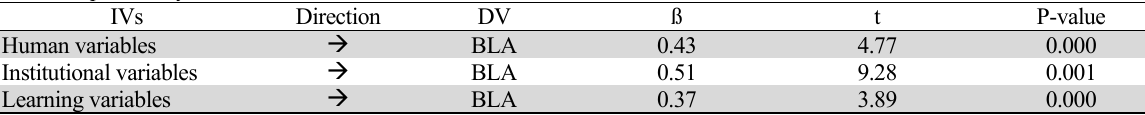
Results of path